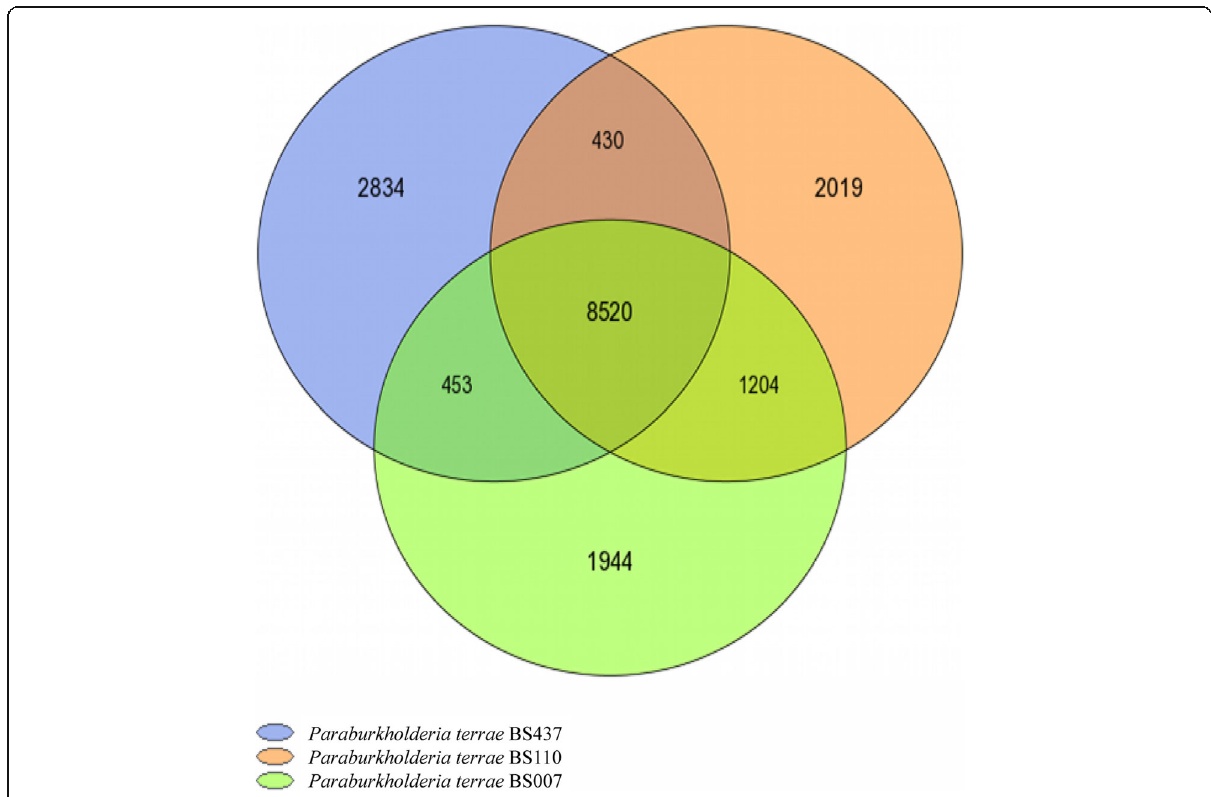
Fig. 4 Core and pan genomes. Venn diagram analysis of Paraburkholderia terrae strain BS007, strain BS110, and strain BS437